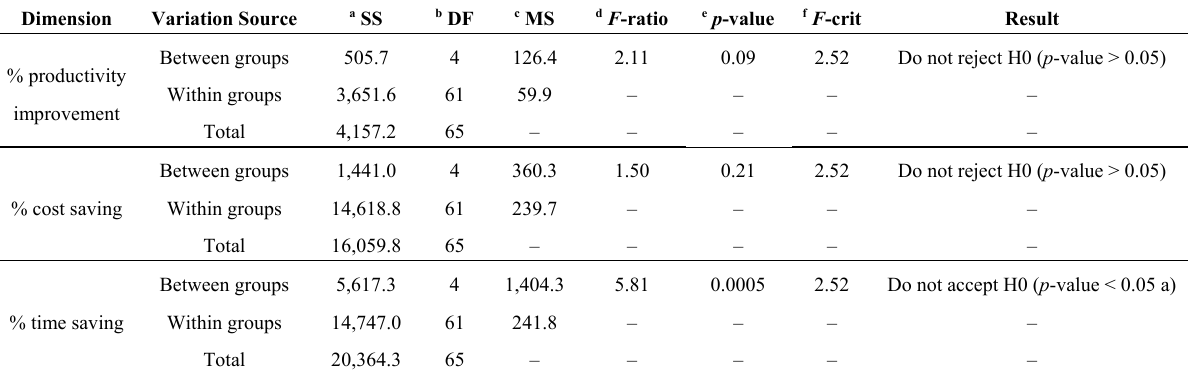
Table 2. Univariate ANOVA analysis results for hypothesis